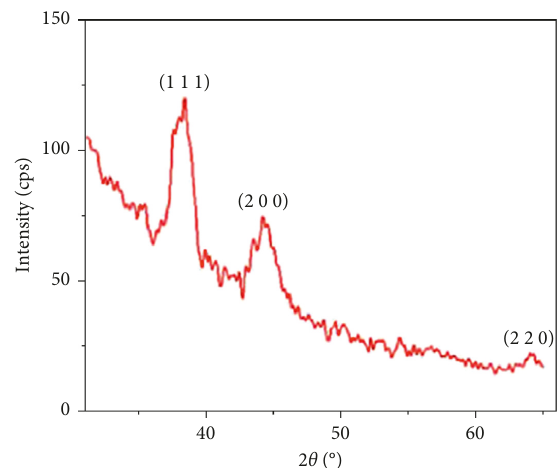
Figure 4: XRD pattern of gold nanorods as prepared by the sonoelectrochemical method [83].